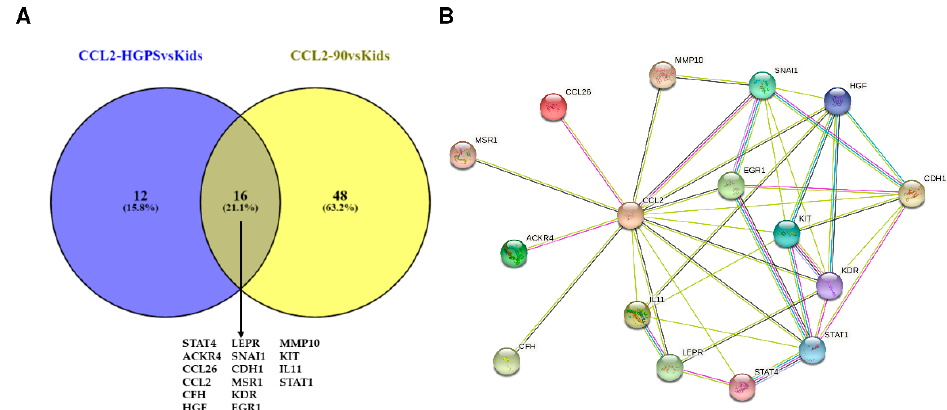
Figure 13. NicheNet and STRING analysis of progeria and aging. ( A ) The 16 common CCL2 interaction partners are the overlapping neighbors of CCL2 in the DEGs of the progeria comparison (blue) and the DEGs of the aging comparison (yellow), respectively. ( B ) STRING network of CCL2 and the 16 CCL2 interaction partners that are differentially expressed in both comparisons.